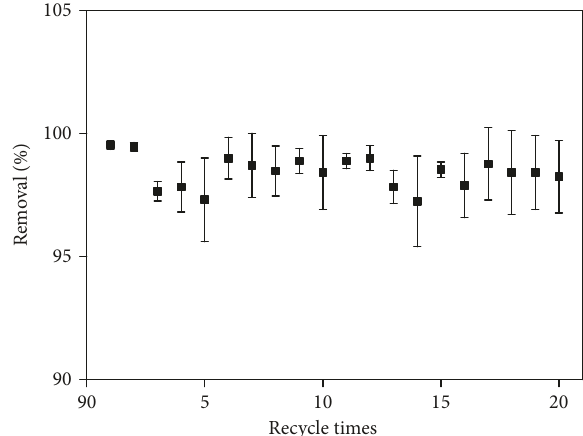
Figure 15: The removal rate of the initial 2,4-DCP solution by T-H-400 under the UV lamp for 1h after 25min in the